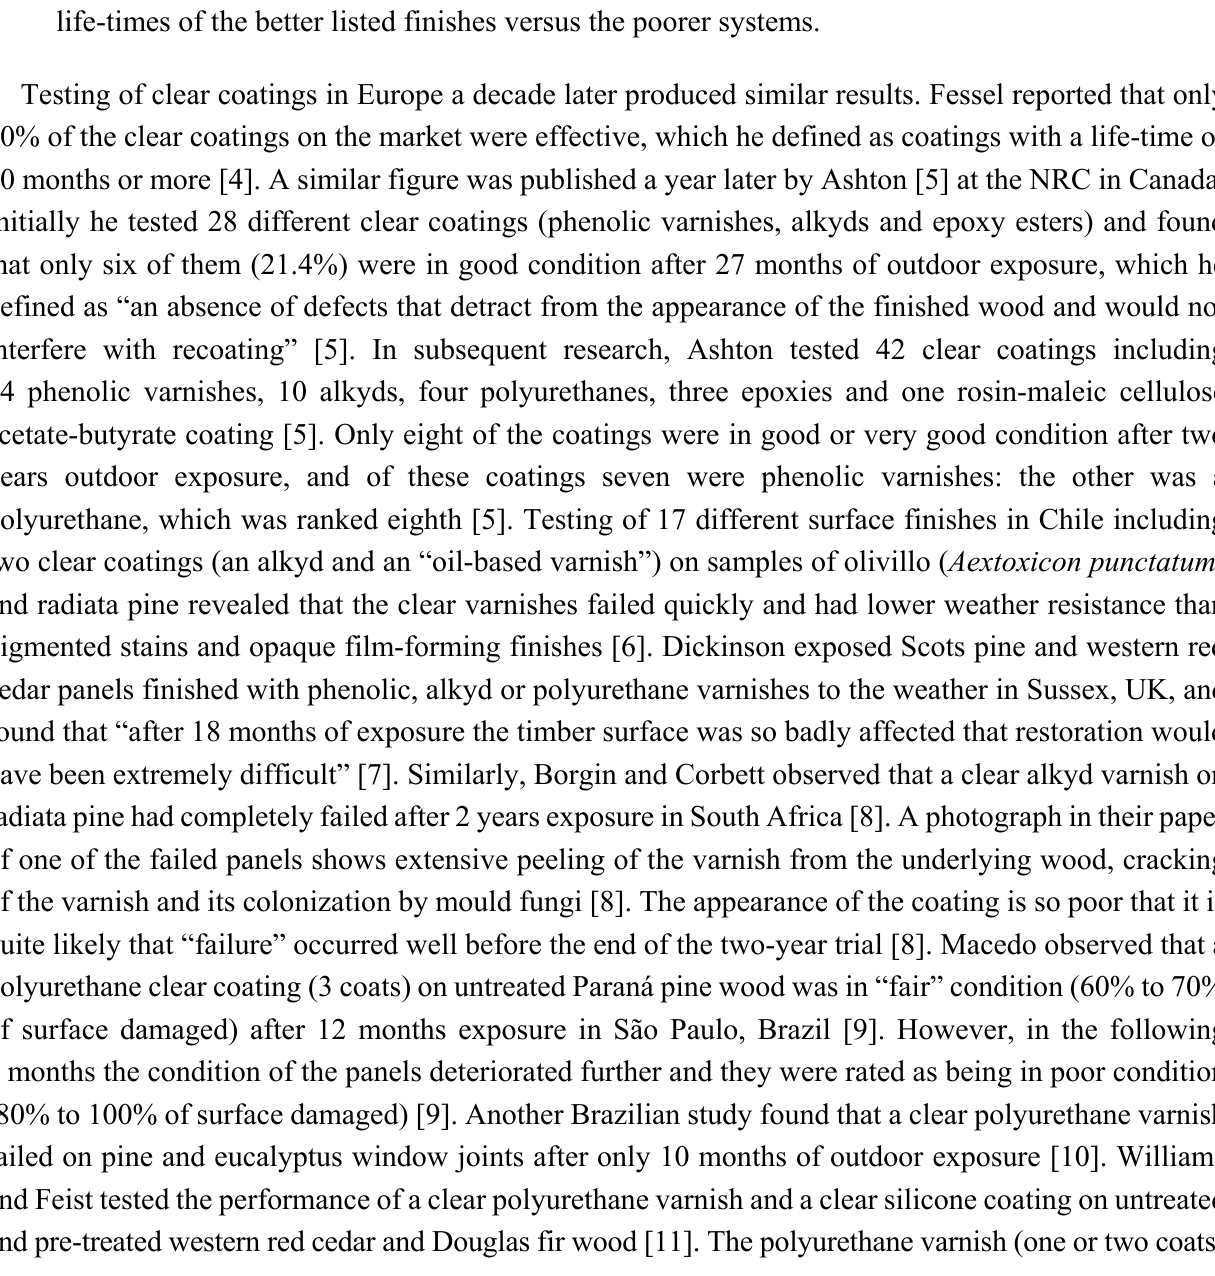
Figure 1. Summary of the results of the California Redwood Association’s testing of clear finishes on wood exposed outdoors (re-drawn using data from Estrada [3]): ( a ) Numbers of finishes tested versus those listed as being suitable for the finishing of redwood; ( b ) Average life-times of the better listed finishes versus the poorer